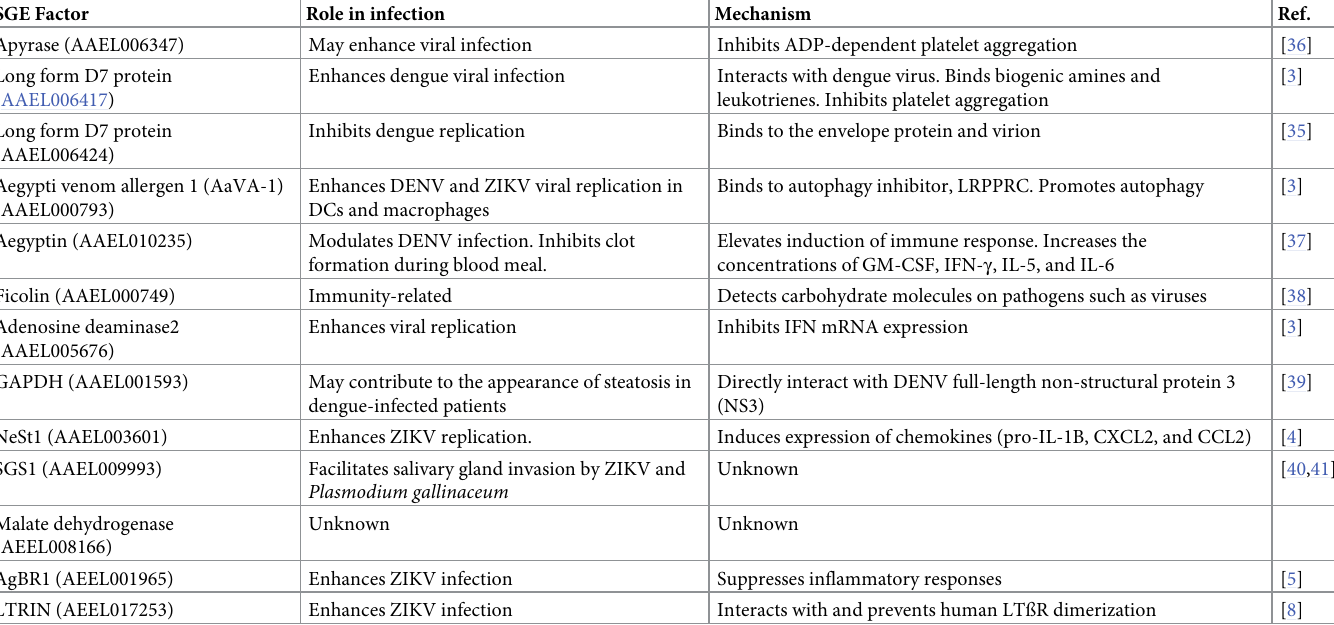
Table 2. Roles of the receptor binding SGPs in virus transmission/infection.